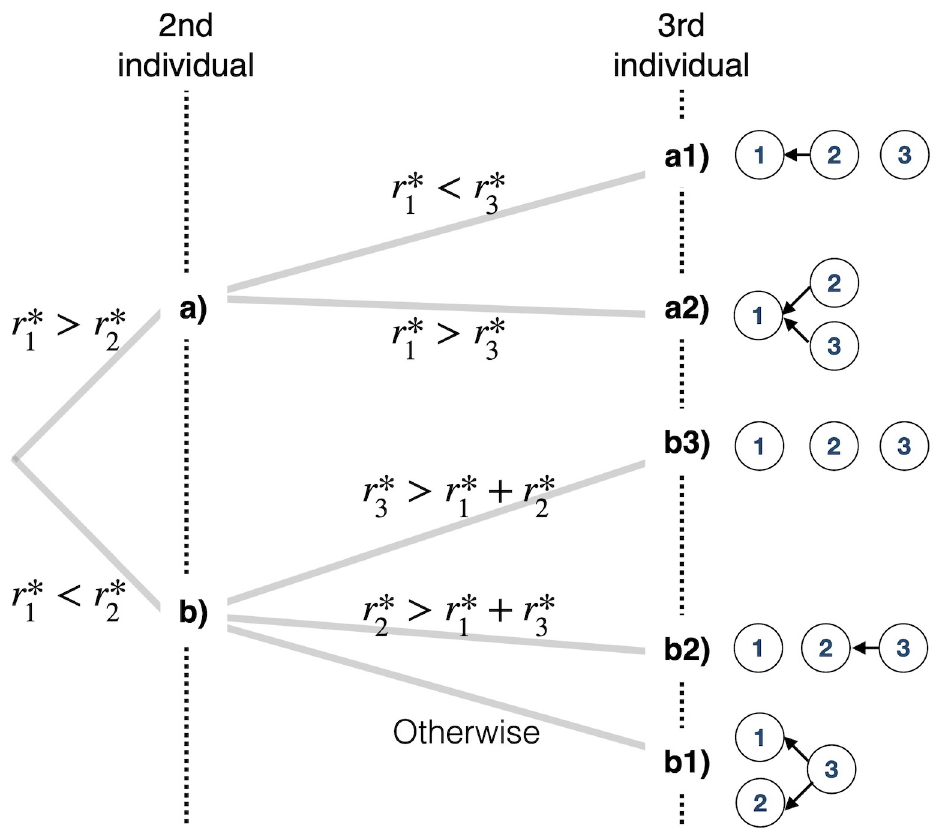
Fig 2. Optimal behaviours of the second and third individuals. The diagram on the right-hand side shows the resulting influential relationship among three individuals by the arrows, each pointing to the individual that one follows. For example, the top diagram (a1) reveals that the second individual incorporates the answer by the first individual, and the third individual decides without referring to others.